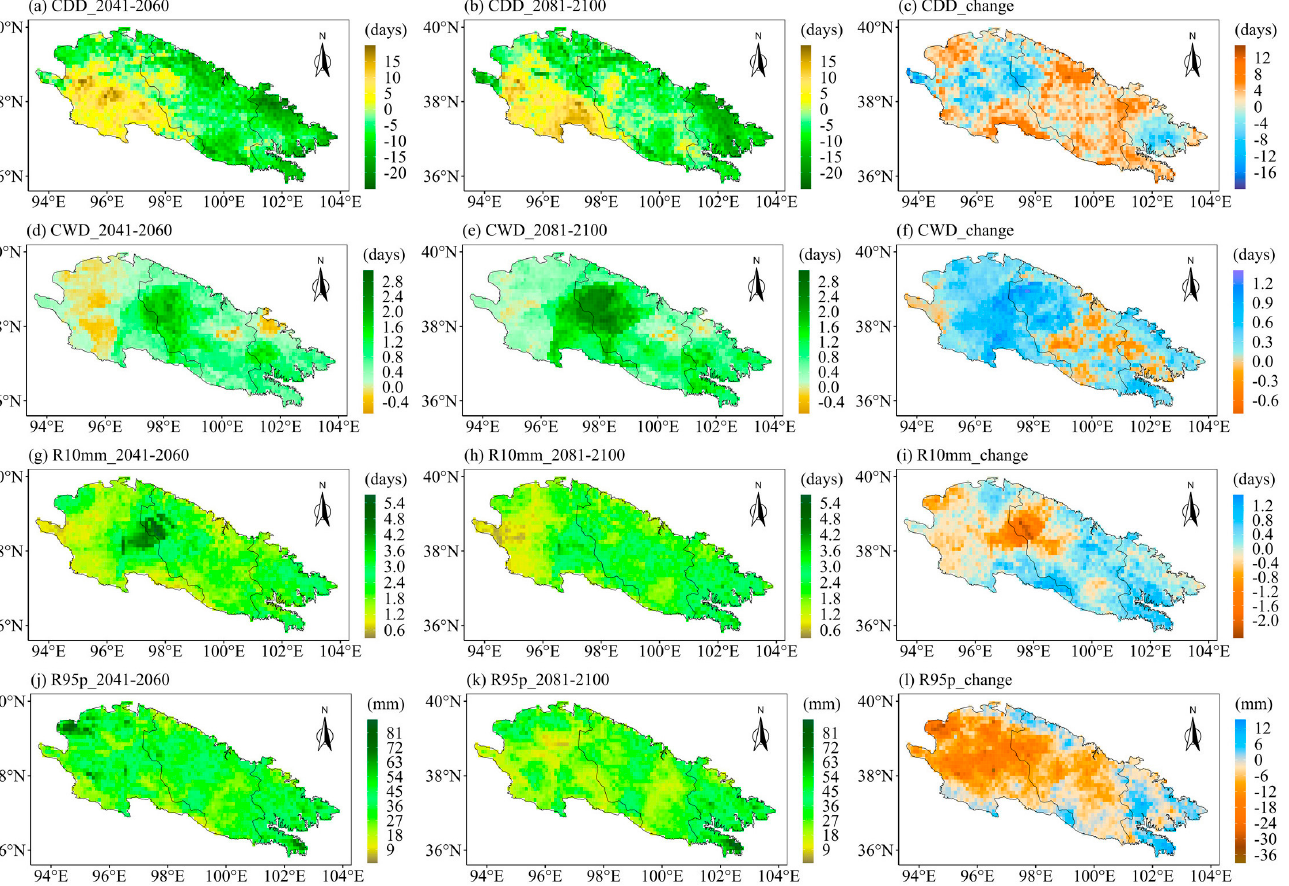
Figure 10. ( left ) The changes of extreme precipitation indices in the middle of the 21st century as compared to the base period, ( middle ) the changes of extreme precipitation indices at the end of the 21st century as compared to the base period, and ( right ) the changes of extreme precipitation indices at the end of the 21st century as compared to the middle of the 21st century. Spatial distribution over the Qilian Mountains under SSP126: ( a – c ) CDD, ( d – f ) CWD, ( g – i ) R10mm, and ( j – l ) R95p. Note that the future change is represented by the ensemble of the corrected CMIP6 models.